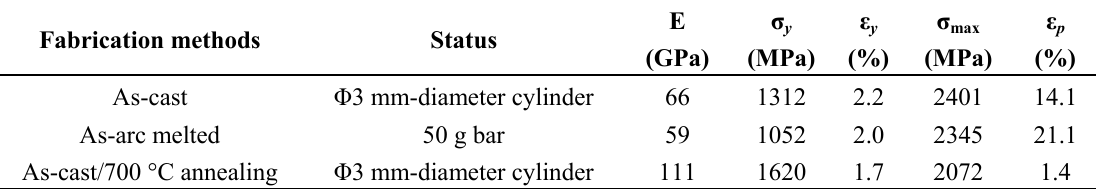
Table 9. Summary of the compressive test data: elastic modulus E , yield strength σ the yield point ε , ultimate compression stress σ y with permission from [143]. Copyright 2005 Elsevier.